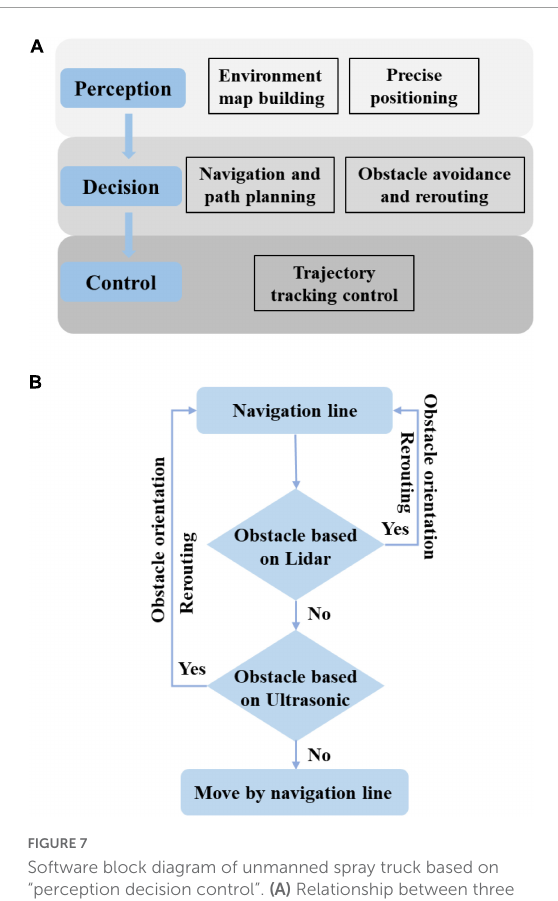
FIGURE7 Software block diagram of unmanned spray truck based on “perception decision control”. (A) Relationship between three layers. (B) Obstacle avoidance fusion output based on decision-level fusion.